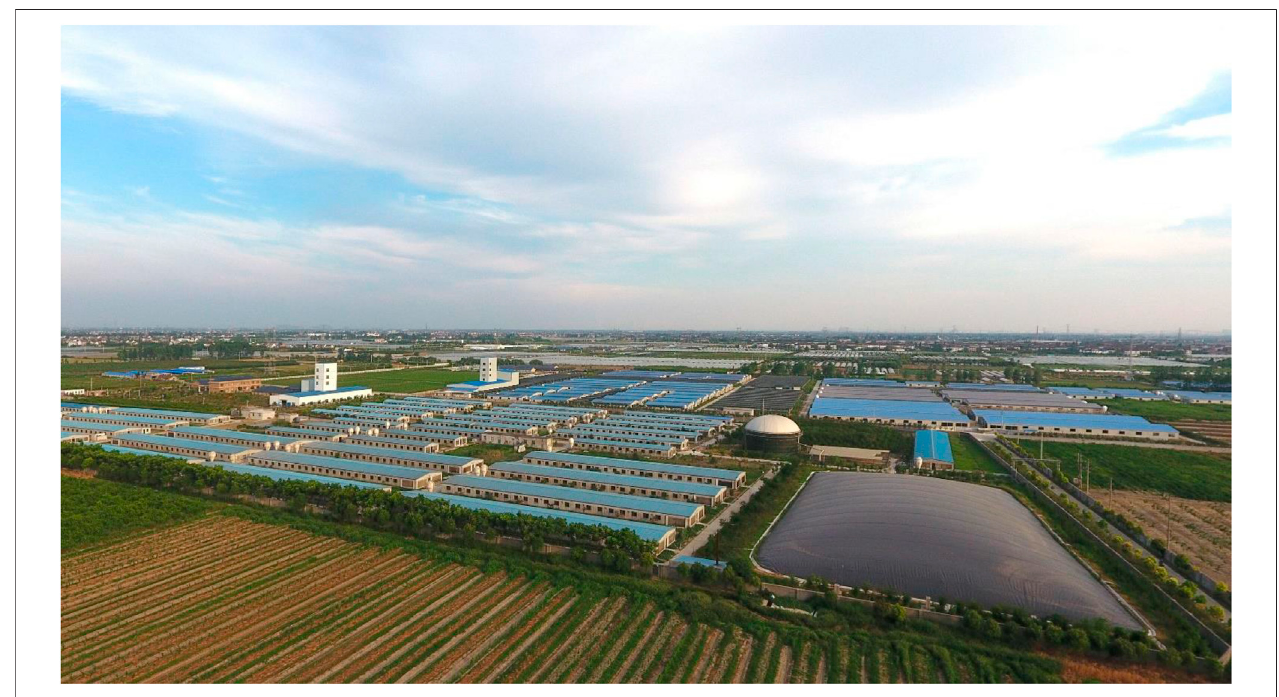
FIGURE 1 | Site image of manure and sewage treatment facilities in the pig farm.